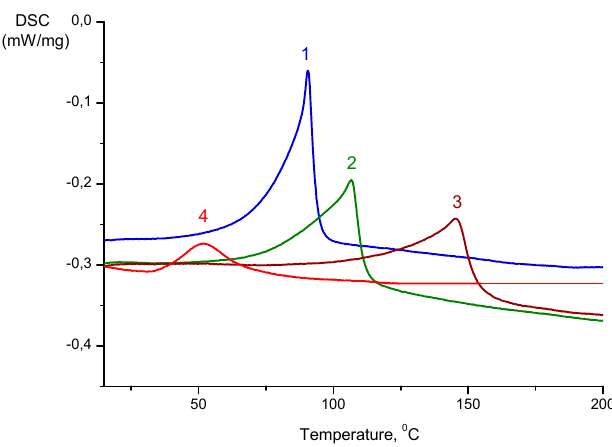
Figure 2. DSC curves of the curing catalyzed by: cis - 4 (1.0 × 10 − 4 mol/L) (1); cis - 4 (5.0 × 10 − 5 mol/L) (2); cis - 4 (1.0 × 10 − 5 mol/L) (3); Karstedt’s catalyst (1.0 × 10 − 5 mol/L) (4).